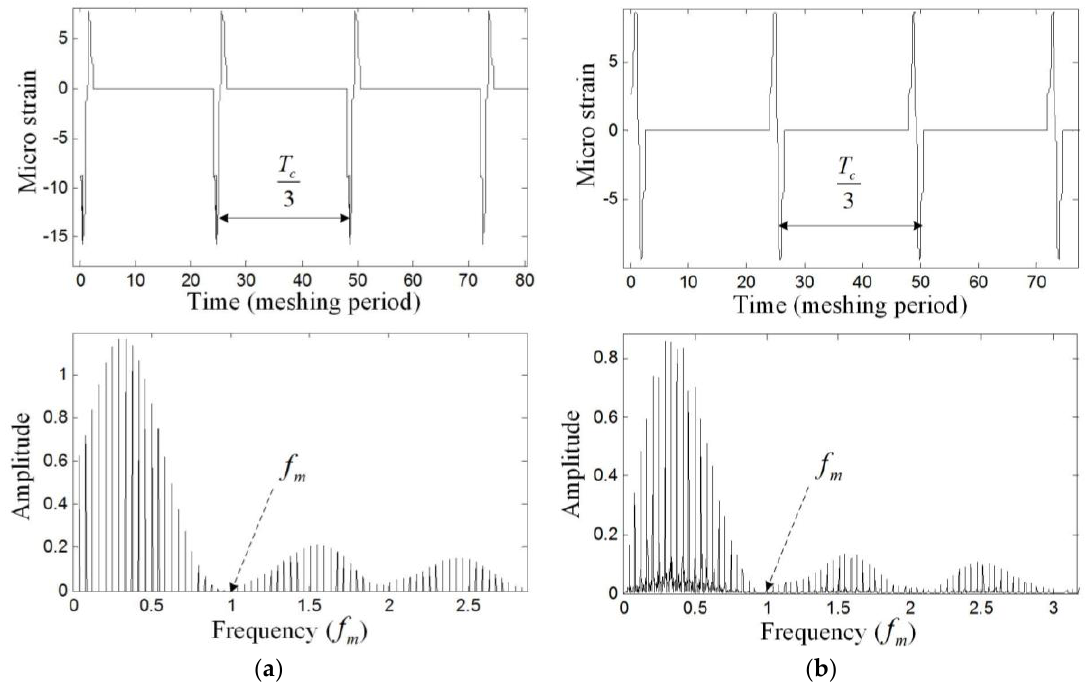
Figure 11. Simulated strain measured by ( a ) FBG1 and ( b ) FBG 2 in the time domain and frequency domain.